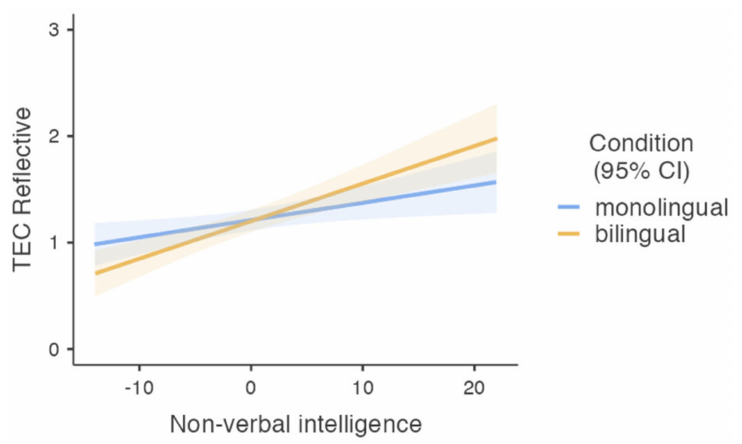
Figure 2. Ability to understand reflective causes of emotions for monolingual ( n = 319) and bilingual ( n = 277) children with different levels of non-verbal fluid intelligence. Colored shades represent the confidence intervals. Note: non-verbal intelligence scores presented as Z